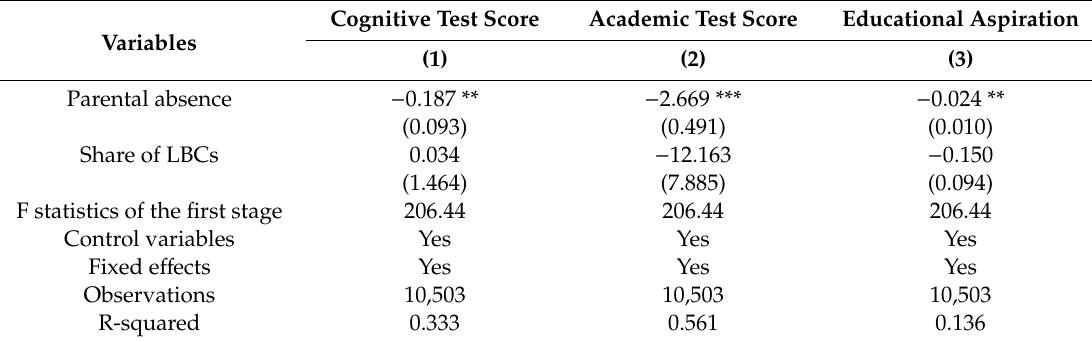
Table 5. IV Estimates of e ff ects of parental absence on students’ academic